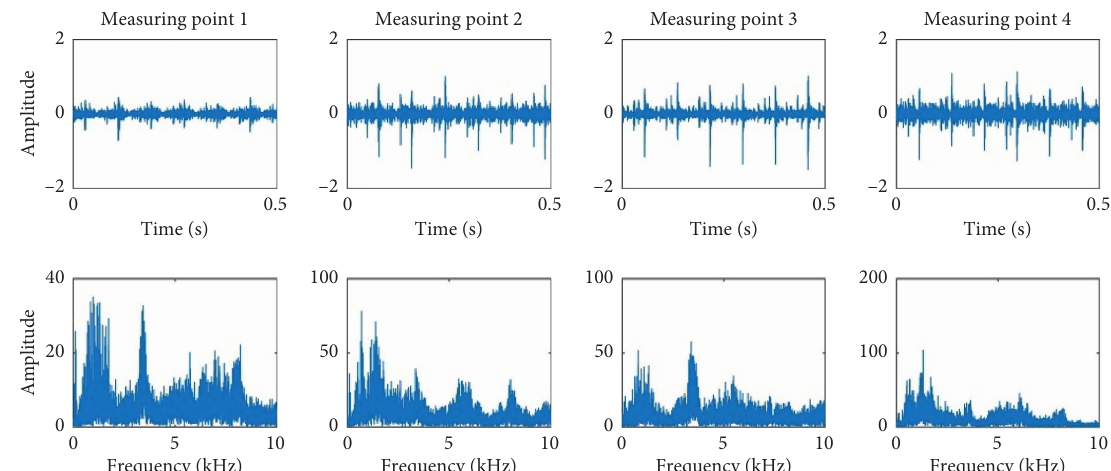
Figure 10: The waveforms of original signals under left 1-cylinder (time domain and frequency domain).